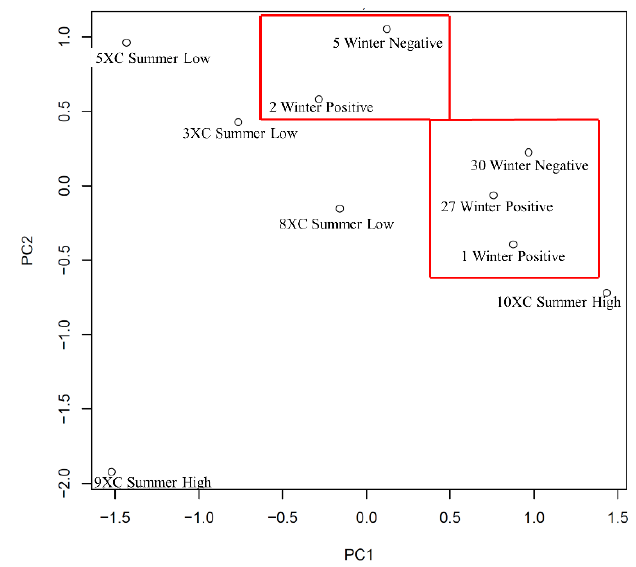
Figure 5. Principal component analysis (PCA) plot generated from the sub-iliac lymph nodes collected from cattle at slaughter in the summer (high or low Salmonella concentrations) and winter ( Salmonella positive or negative). The kinome profiles of these animals were plotted by PCA. SD% of PC1 = 22.42%; SD of PC2 = 19.34%.